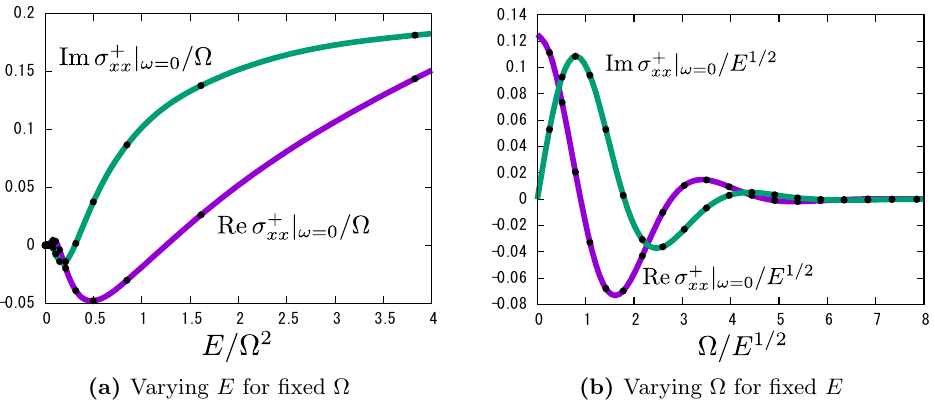
Figure 11. Conductivity (cid:27) +